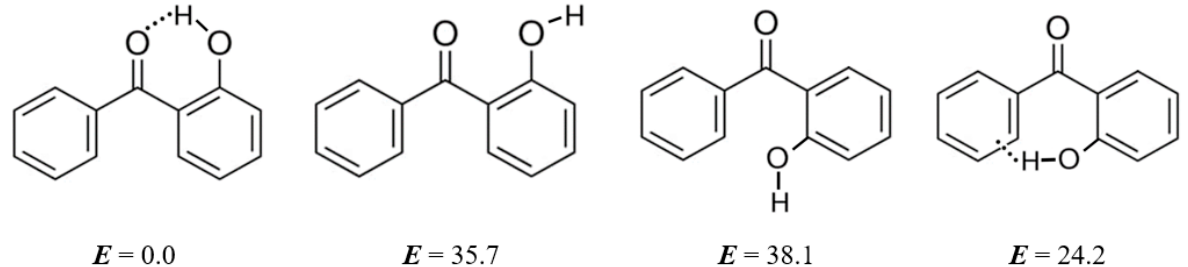
Figure 14. Determination of the intra ‐ molecular hydrogen bonding strength in 2 ‐ hydroxy ‐ benzo ‐ phenone using the “HB and Out” method and an alternative phenyl group rotated 180° around the C ‐ C axis. (All values in kJ ∙ mol − 1